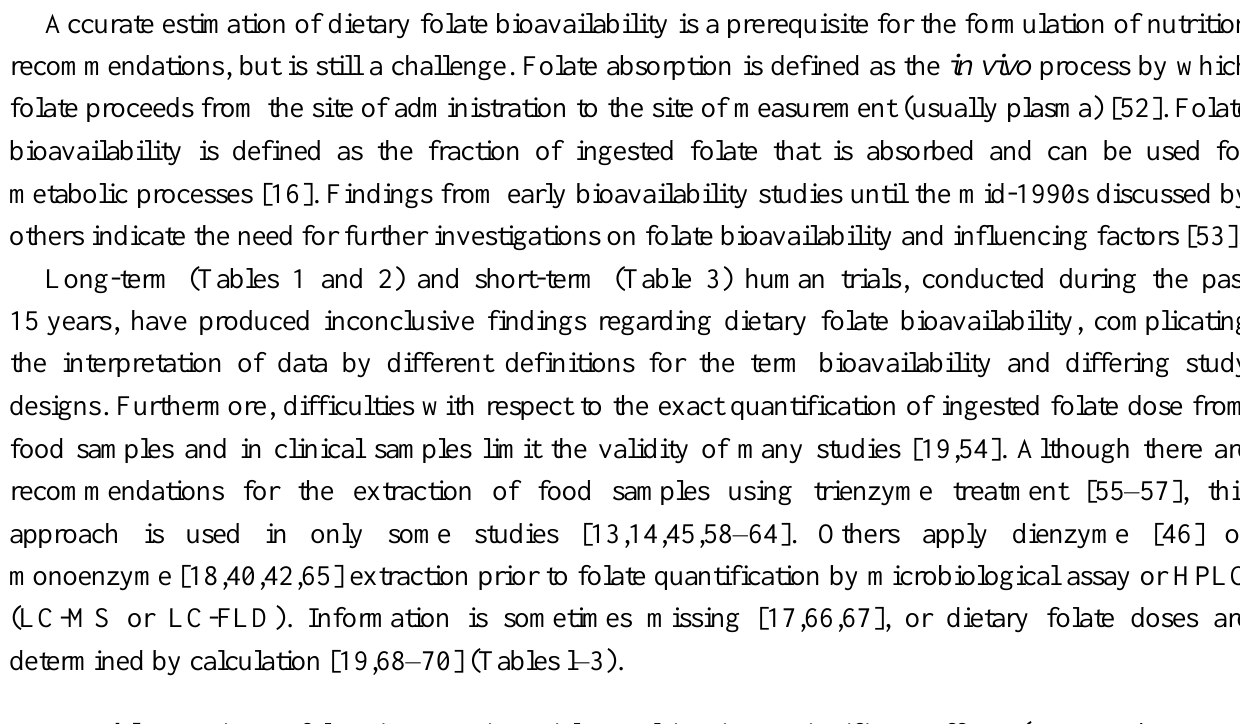
Table 1. Dietary folate intervention trials resulting in no significant effects (presented as change (%) compared with baseline) on folate